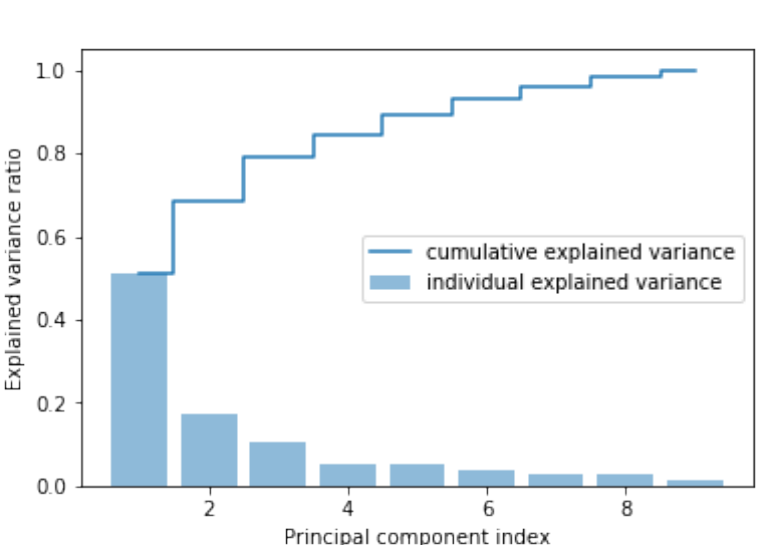
Figure 4. Variance in the load dataset (for HAM) covered by principal